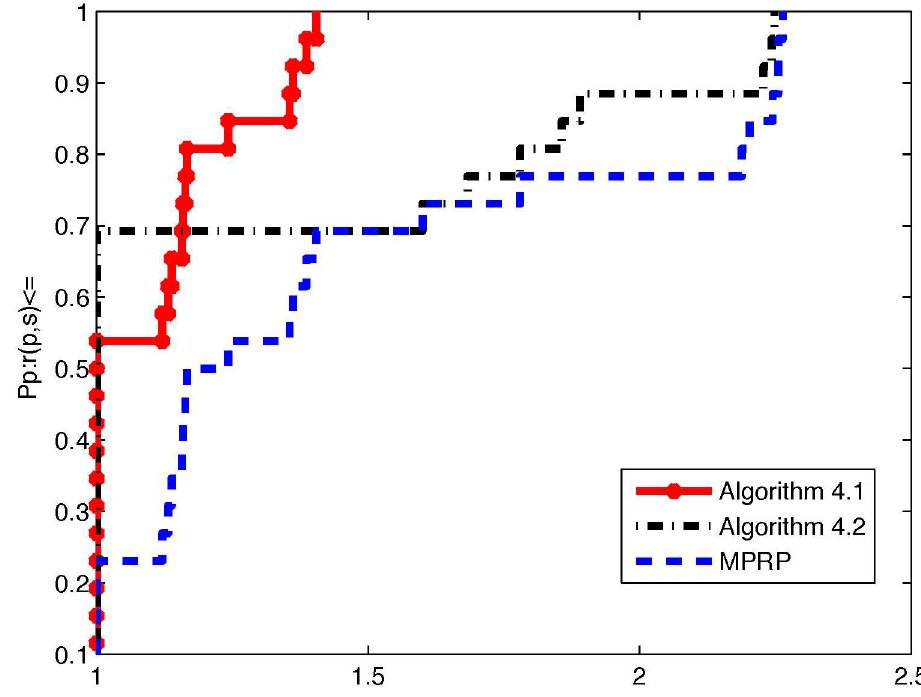
Fig 2. Performance profiles of these methods